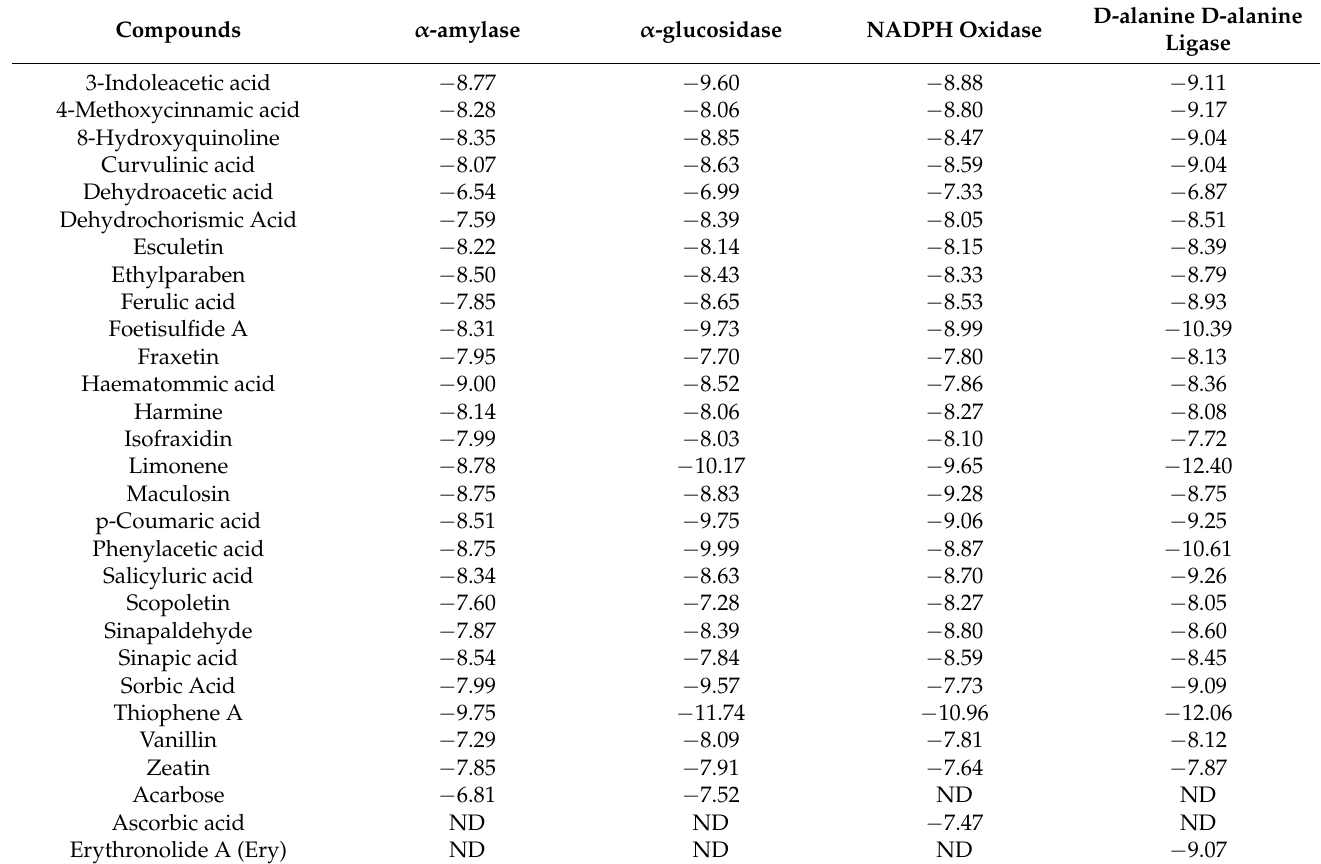
(Table S4) against the ligands during the docking run are also summarized. Among the selected ligands, thiophene A exhibited the highest binding energy (kcal/mol) with the target α -amylase ( − 9.75), α -glucosidase ( − 11.74), NADPH oxidase ( − 10.96), and D-alanine D-alanine ligase ( − 12.06) proteins (Table 7). The docking simulation of thiophene A with the crystal structure of α -amylase and α -glucosidase during the in silico molecular interac- tion is shown in Figure 6a–d. Interaction of thiophene A with α -amylase was not related to H-bonding and C-H bonding, but was associated with 11 VDIs (TRP58, TRP59, GLU60, GLN63, GLY104, SER105, GLY106, GLY164, ARG195, ASP197, and ASP300) (Figure 6b and Table S3). With α -glucosidase, thiophene A interacted through three VDIs (THR700, ALA704, and GLN776) and other non-covalent interactions (Figure 6d and Table S3). Fur- thermore, Figure 7a–d depict the in silico molecular docking simulation of thiophene A with the crystal structure of NADPH oxidase and D-alanine D-alanine ligase. However, the docking of thiophene A with NADPH oxidase and D-alanine D-alanine ligase indicated six VDIs (HIS10, PHE14, GLY59, ARG308, PRO816, and ARG882) and five VDIs (ASN129, GLU203, GLU451, ASP590, and SER589), respectively (Figure 7b,d and Table S4). Table 7. Free binding energies of the tentatively identified compounds from the EAE-PR within the active pockets of α -amylase (PDB: 1OSE), α -glucosidase (PDB: 5NN8), NADPH oxidase (PDB: 2CDU), and D-alanine D-alanine ligase (PDB: 2PVP) during the in silico molecular dock- ing analysis. ND, not determined.